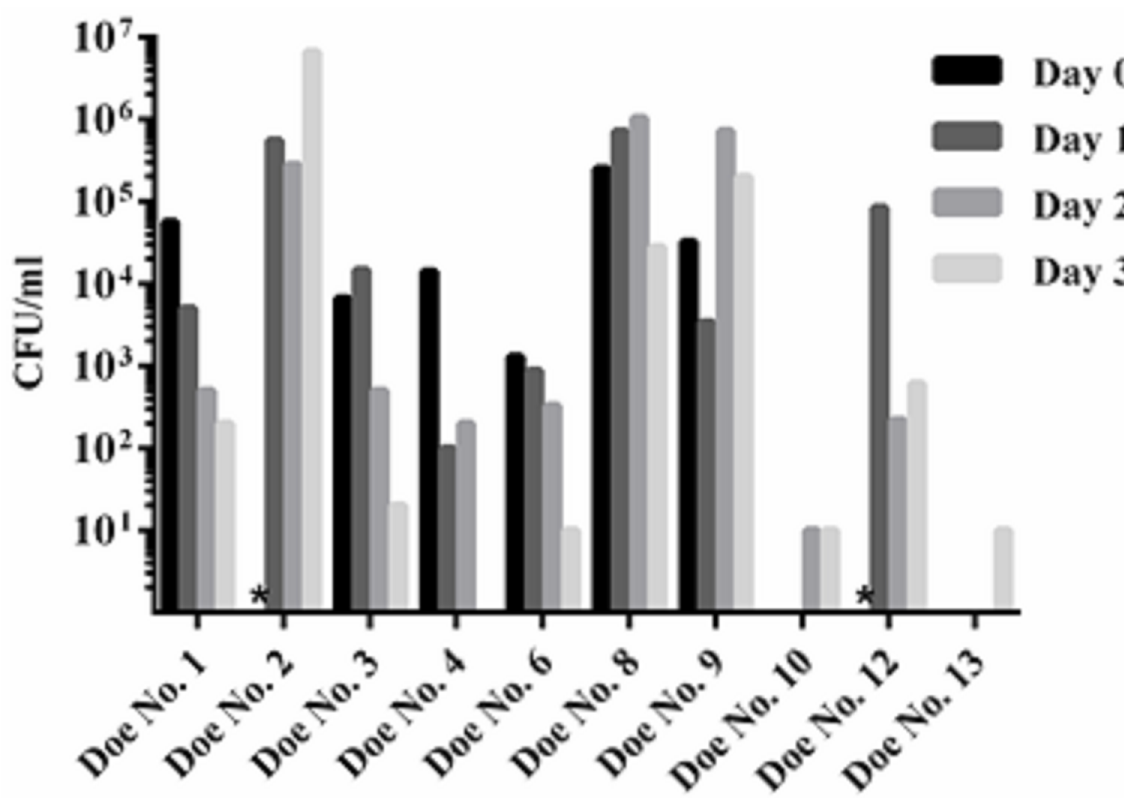
Fig 2. Shedding of B . melitensis 16M and Rev. 1 in milk. Sheddingis measuredin CFU of B . melitensis 16M (does 1–9) or Rev. 1 (does 10–13)per ml of milk cream/pellet. Limit of detection is 10 CFU. The absenceof a bar indicatesthat Brucella was not isolated, except where an asterisk is placedto indicate that cultures were contaminated or not collected.Data from does 5, 7, and 11 are not includedsince these animalswere not pregnant.